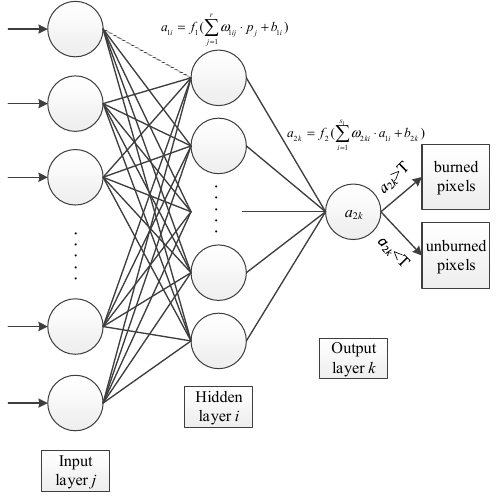
Figure 4. Framework of the back-propagation neural network (BPNN) in our method.